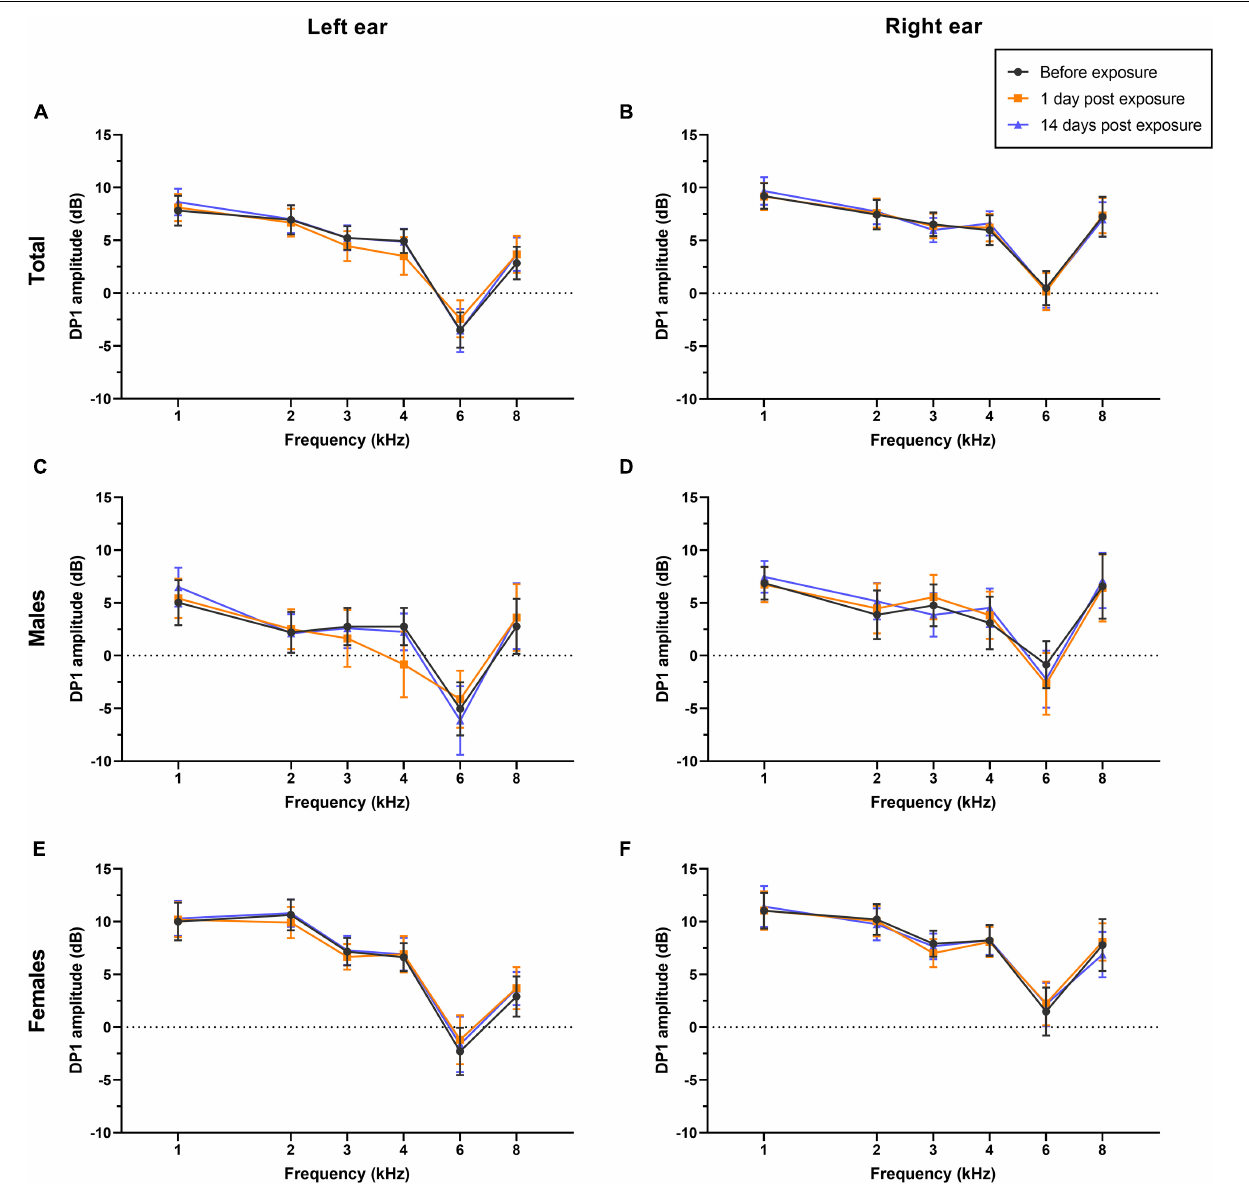
FIGURE 4 | Effects of noise exposure on DPOAE. There were no statistically significant differences in the DPOAE amplitudes of either ear at frequencies of 1–8 kHz in the overall sample (A,B) , in males specifically (C,D) , or in females specifically (E,F) among baseline (black), 1 day after outdoor music festival noise exposure (orange) and 14 days (blue) after exposure. Analyses were performed by the two-way repeated measures